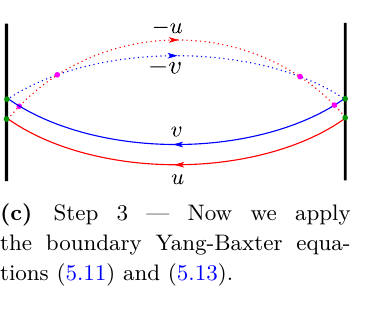
[ˆ T 4 ( ˆ T 4 ( u ) , v )] = 0